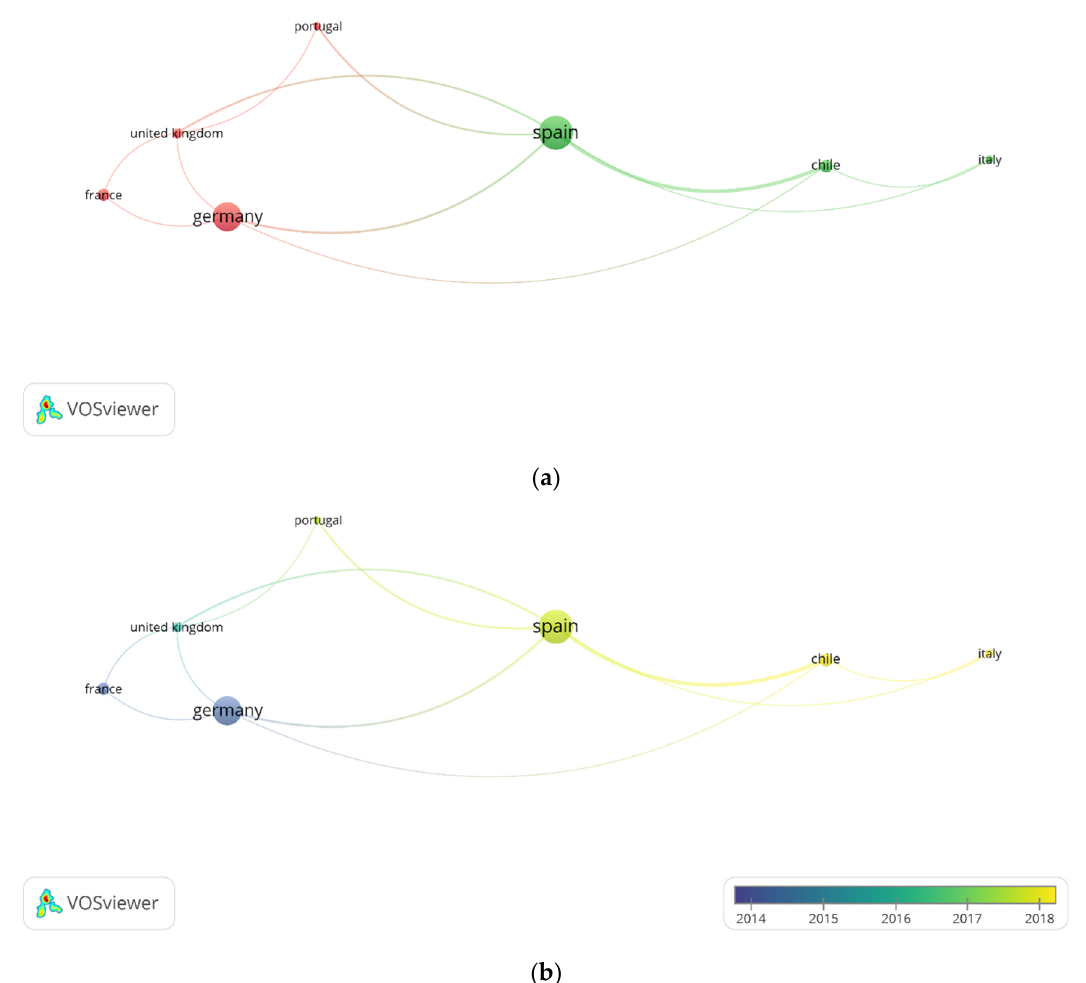
Figure 8. Relationships between EU countries. ( a ) Relationships between country clusters, and ( b ) Highlights of the date of publication.